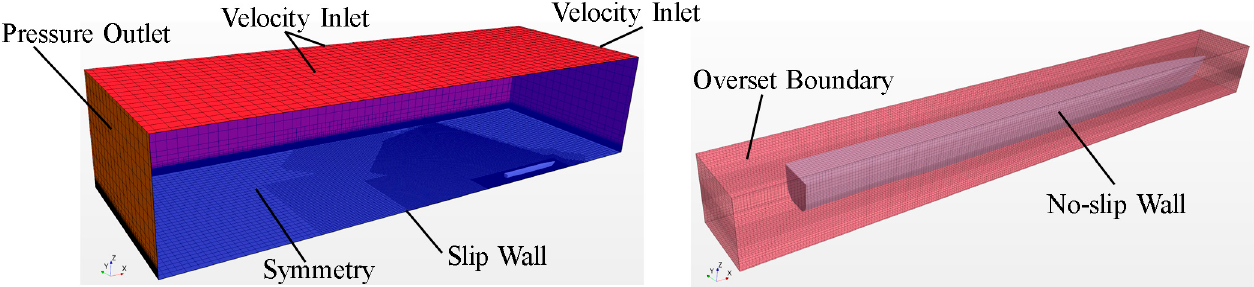
Figure 3. Computational domains ( left : Tank Region; right : Hull Region) and boundary conditions.